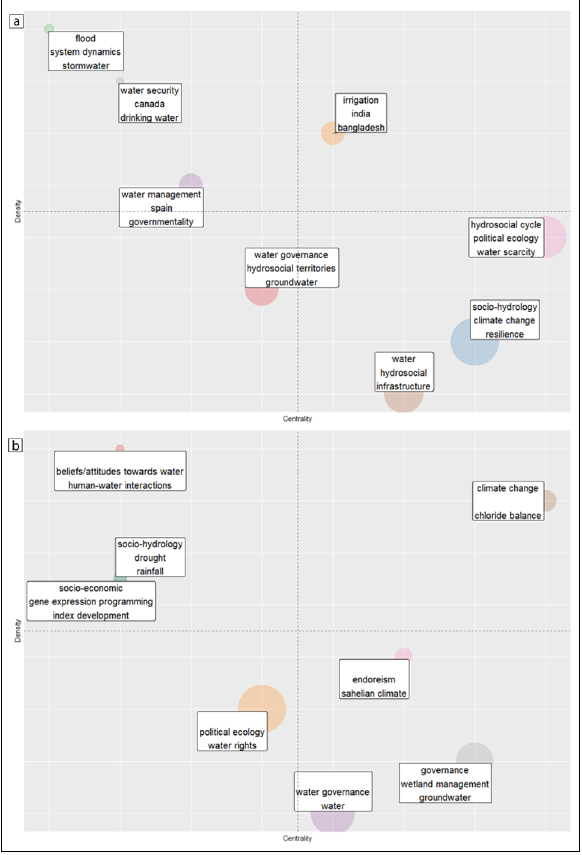
Figure 5: Thematic map of publications (a) globally and (b) in